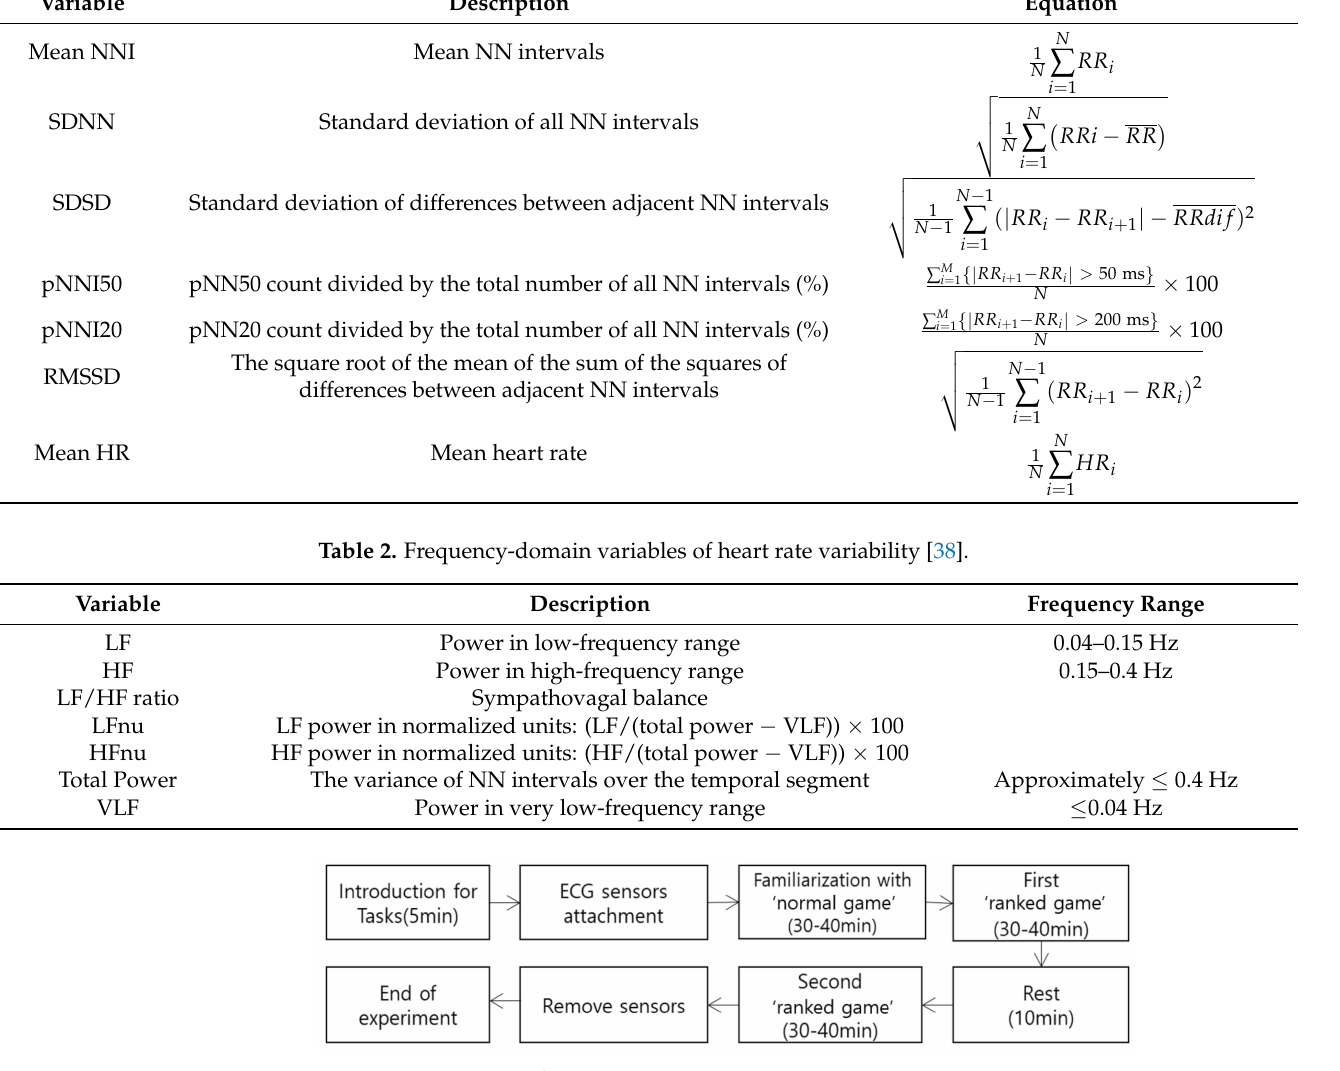
Figure 2. Experimental